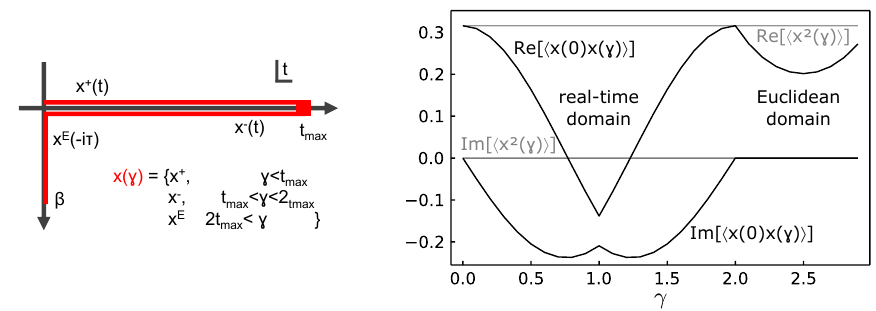
Figure 2 . (left) Sketch of the Schwinger-Keldysh contour deployed in our study with forward x + ( t ) and backward x − ( t ) branches on the real-time axis, connected to an imaginary time branch x E ( − iτ ) . The contour parameter γ is used to address all branches in a unified manner. (right) Sketch of the visualization of our observables along the contour parameter γ for the example of mt = 1 . max The analytic solution of the real- and imaginary part of the equal time correlator h x 2 ( γ ) i and the unequal time correlator h x (0) x ( γ ) i will be plotted in the real-time γ < 2 mt and subsequently max Euclidean domain γ > 2 mt max